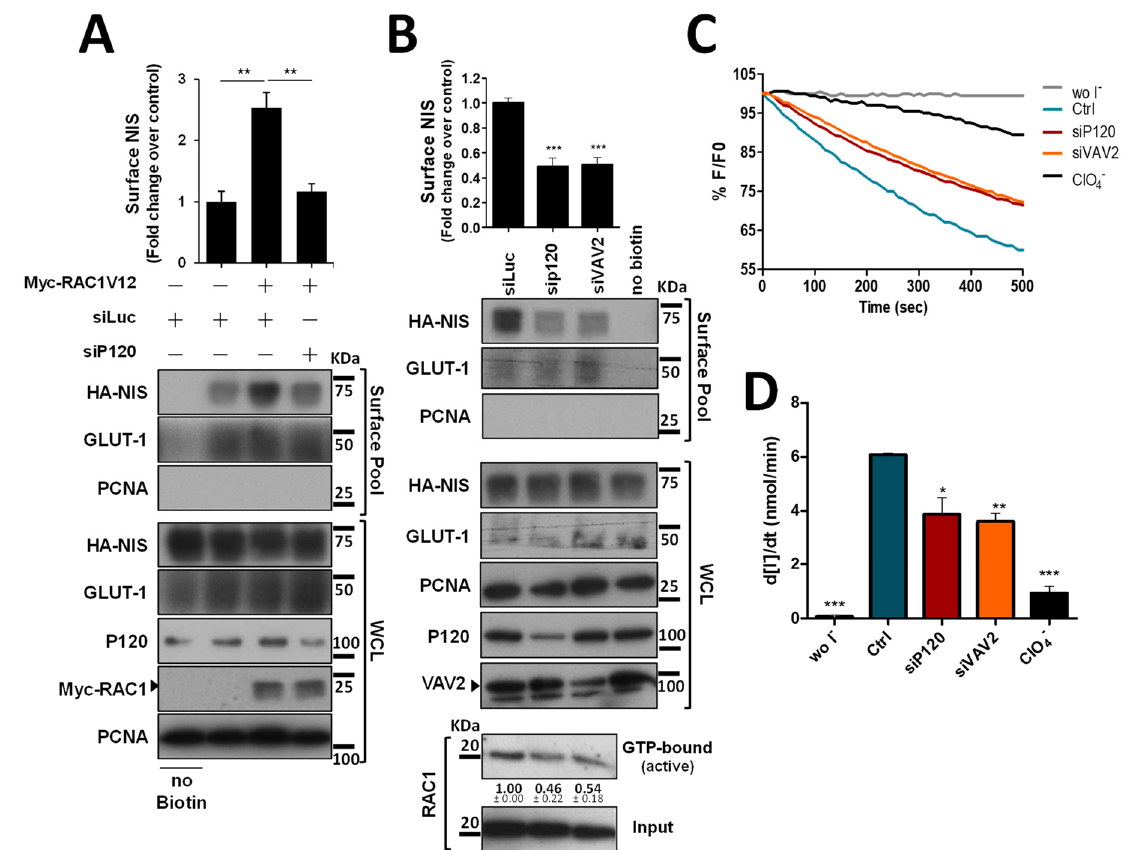
Figure 5. P120 participates in the RAC1-mediated upregulation of NIS PM residency. ( A ) HA-NIS- TPC1 cells were transfected with either an empty vector (Empty) or GFP-RAC1-V12 or with either mock (siLUC control) or a specific siRNA against P120 (siP120), as indicated. ( B ) HA-NIS-TPC1 cells were transfected with either mock (siLUC control), a specific siRNA against P120 (siP120), or a specific siRNA against VAV2 (siVAV2), as indicated. In addition, endogenous RAC1 activation status upon either P120 or VAV2 knockdown was assessed by monitoring the active GTP-bound fraction of RAC1 (using the CRIB domain pull-down assay) and comparing it to total (input) RAC1 levels, using anti-RAC1 primary antibody by WB. NIS-PM levels ( A , B ) were assessed by surface protein biotinylation and WB as described in Figures 1, 2 and 4. The plotted values correspond to the means ± SEM of at least three independent assays. One-way ANOVA analysis detected significant differences between the treatments (F = 19.30 and p = 0.0024 for ( A ); F = 33.59 and p < 0.001 for ( B )). Significant variations relative to the control conditions or among the different treatments (indicated by horizontal lines) were identified by Tukey’s posthoc tests (** p ≤ 0.01; *** p ≤ 0.001). ( C ) Representative traces of the iodide-induced YFP fluorescence decay of HA-NIS/HS- YFP-TPC1 cells treated as in ( B ) and analyzed as described in Figure 1. ( D ) Iodide influx rates were derived from the decay curves. Data are the means ± SEM of at least three independent assays. Significant variations were detected by one-way ANOVA (F = 27.48; p < 0.001) followed by Dunnett’s posthoc test, compared to control conditions (Ctrl) (* p ≤ 0.05; ** p ≤ 0.01; *** p < 0.001). The uncropped bolts are shown in Supplementary Materials File S1.